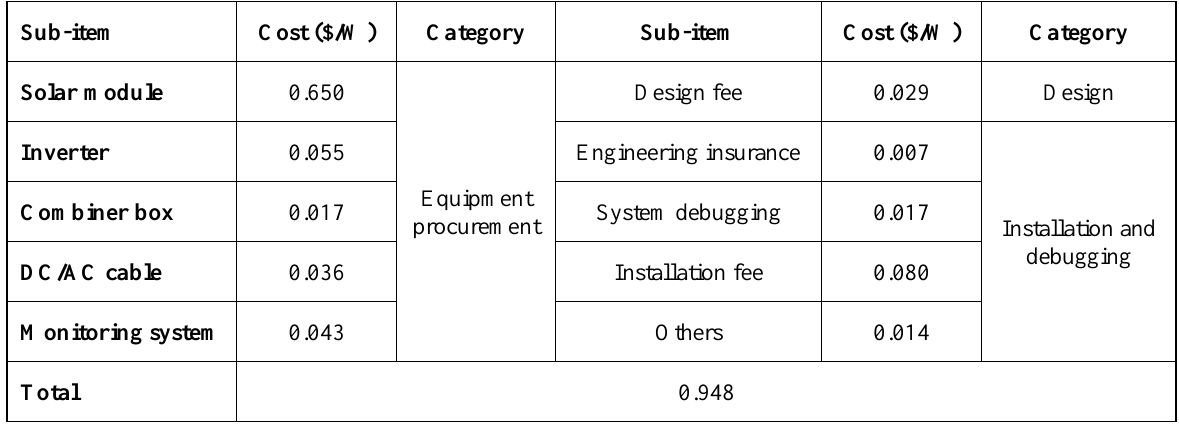
Table 2. Cost breakdowns of the industrial distributed PV system (Manman, 2019; Patel,